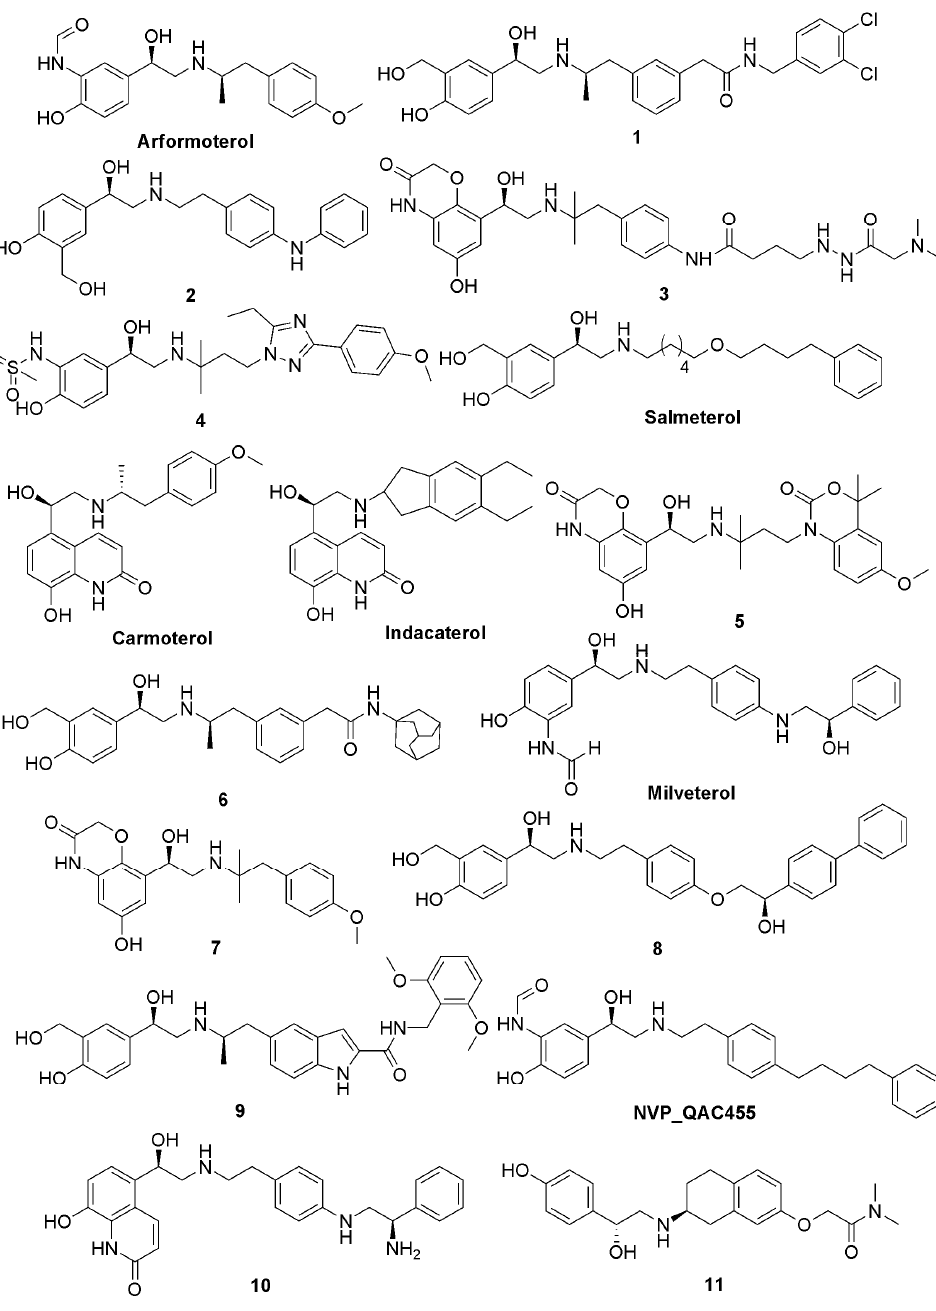
-agonists used to construct the HipHop 2